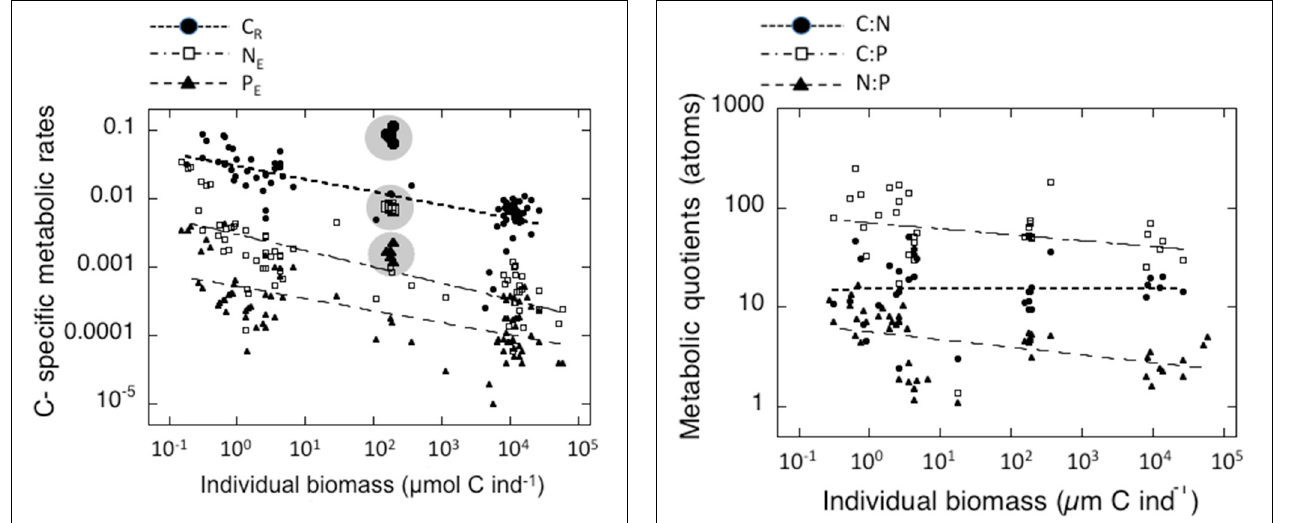
FIGURE 3 | Relationships between individual biomass of experimental zooplankton ( µ mol C ind − 1 ) and metabolic quotients in atoms. Black dots: C R :N E ; Open squares: C R :P E ; black triangles: NE: PE. The corresponding equations are indicated in Table 3B . Table 4 | Zooplankton biomass ( µ mol C m − 3 ), average metabolic carbon requirements (theoretical carbon ingestion, C I ),